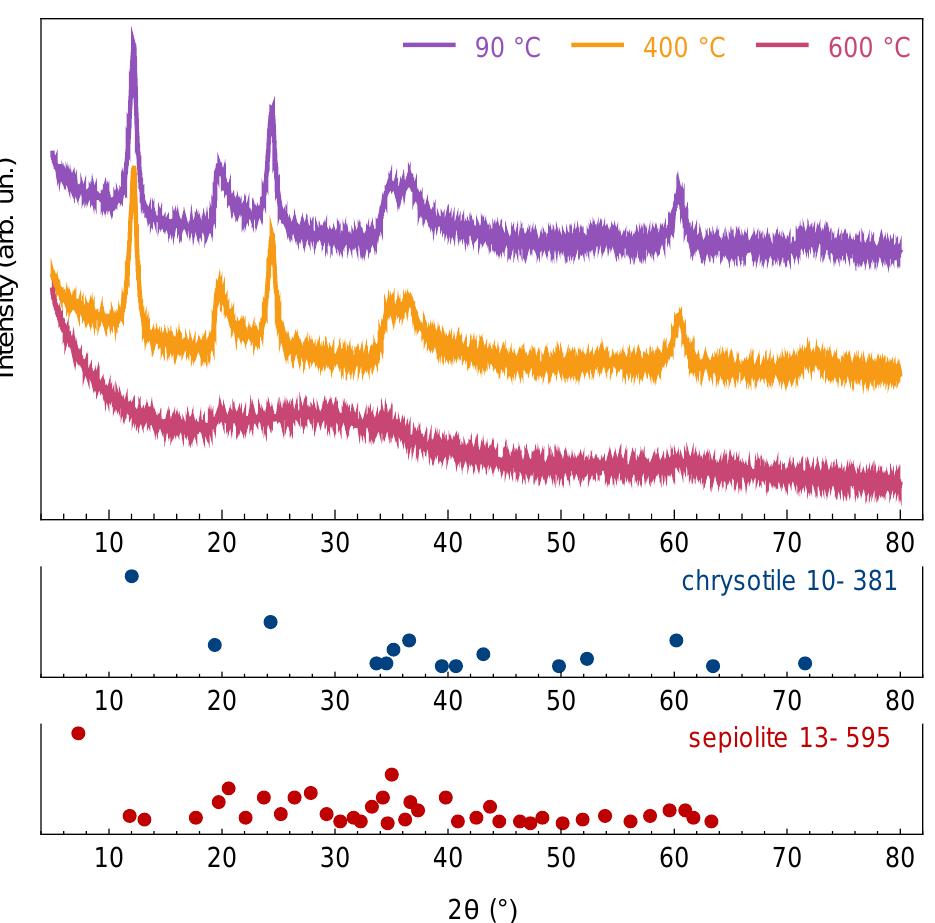
Figure 4. X-ray diffraction patterns and phase analysis of hydrothermal treatment products after drying at 90 °C and after heat treatment at 400 and 600 °C. Phase analysis was carried out using the ICDD PDF-2 database.